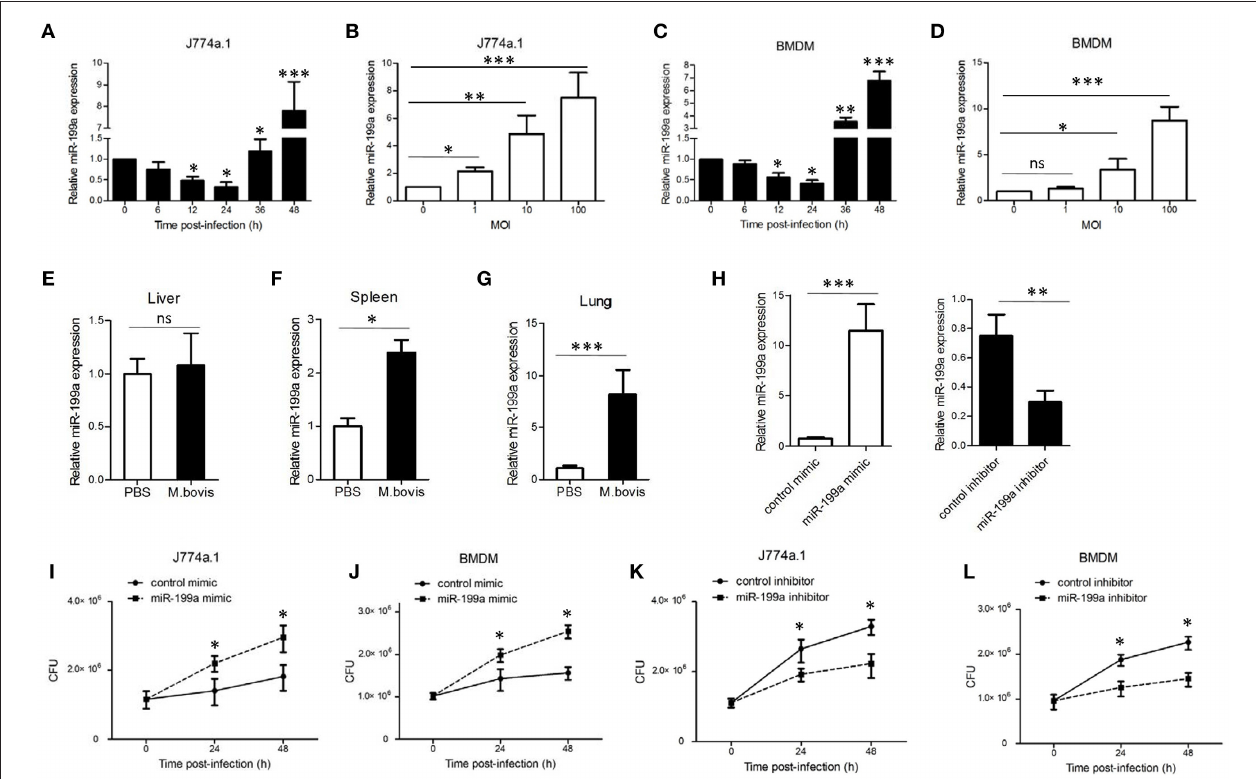
FIGURE 1 | Mycobacterium bovis ( M. bovis )-induced upregulation of miR-199a is associated with increased bacterial survival. miR-199a expression was detected by Quantitative Real-Time PCR(qRT-PCR). (A,B) J774a.1 cells or (C,D) mouse bone marrow monocyte-derived macrophages (BMDMs) were infected with M. bovis at a multiplicity of infection (MOI) of 10 for the indicated time or for the indicated MOI for 48h. (E–G) Mice ( n = 5) were intranasally infected with M. bovis (at a dose of 200 CFU/mouse) or PBS. After 4 weeks, mice were sacrificed and livers, spleens, and lungs were collected for qRT-PCR. (H) Cells were transfected with miR-199a mimic or inhibitor for 24h and then infected with M. bovis at a MOI of 10 for 24h. miR-199a expression was measured by qRT-PCR. Forced expression (I,J) or inhibition (K,L) of miR-199a enhanced or reduced bacterial survival at a MOI of 10 for 24 and 48h post-infection. Data is presented as mean ± SD in three